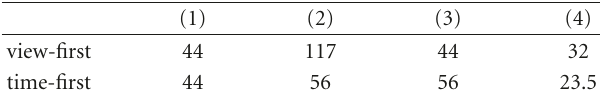
Table 1: Comparison examples between view-first and time-first when di ff erent scenarios are